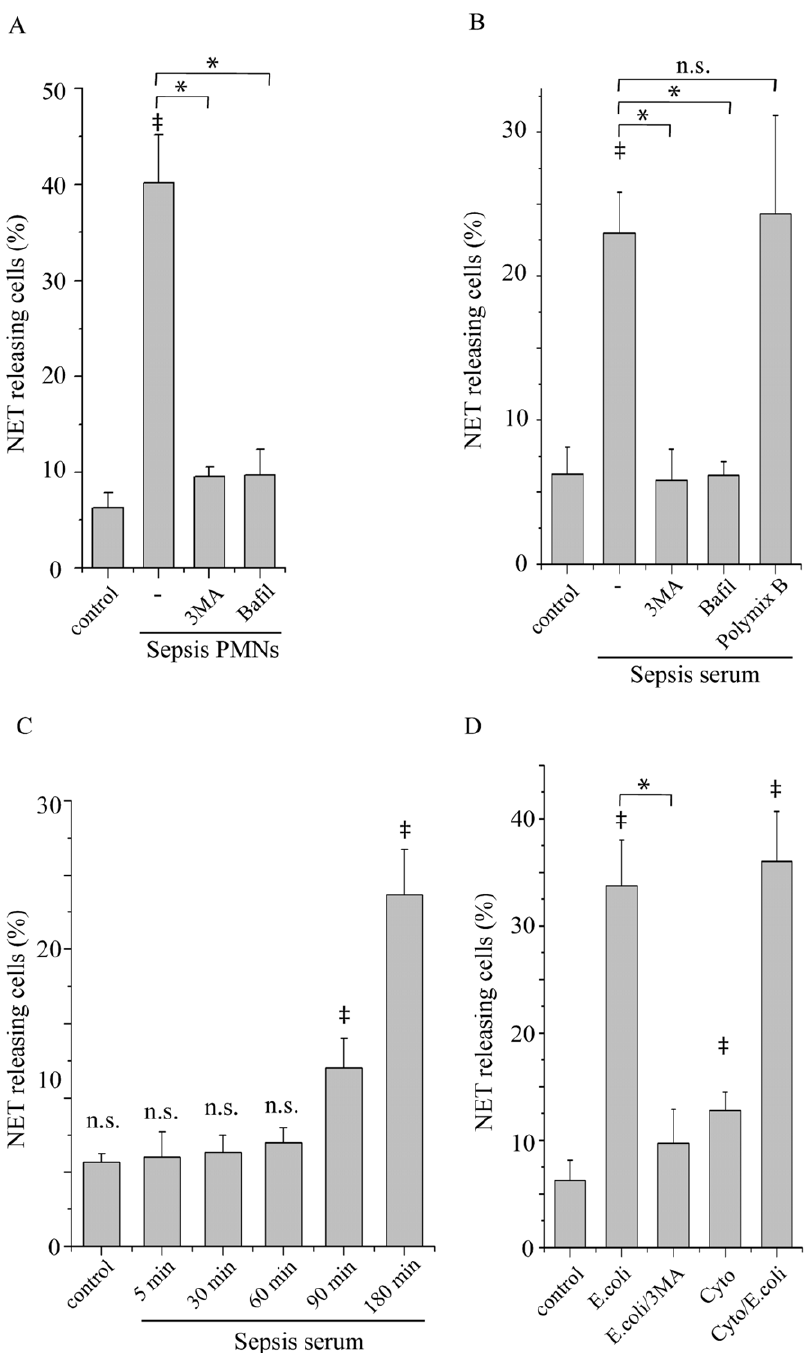
Figure 1 . NET formation by sepsis neutrophils and control neutrophils under inflammatory stimuli. Percentage of neutrophils releasing NETs from (A) sepsis patients (Sepsis PMNs) and (B) neutrophils from control subjects treated with sepsis serum (Sepsis serum) or (D) phagocytosing opsonized E. coli bacteria (E. coli) alone or in the presence of a mixture of TNF- a , IL-1 b and G-CSF (Cyto/E.coli) after 3 h or incubation in the presence of 3-MA (3MA) or bafilomycin A1 (Bafil) or polymixin B (B) or not. The percentage of NET releasing neutrophils after treatment with sepsis serum at different time points is shown in (C). Untreated neutrophils from healthy subjects were used as control. Quantification of percentage was performed on the count of 200 cells per sample. Data are representative of six independent experiments (A, B, D) or three independent experiments (C) and presented as mean 6 SD. ( { P , .05 compared to control, * P , .05). doi:10.1371/journal.pone.0045427.g001 IL-1 b in the pathomechanism of sepsis [31], control neutrophils phagocytosing neutrophils (Fig. 1C), we observed TF localization were stimulated with TNF- a , IL-1 b and G-CSF. Even though the in NETs (Fig. 3A–B), while cellular TF levels were upregulated (Fig. 3C). To further enhance NET production, neutrophils were percentage of NET-releasing cells was lower compared to E. coli